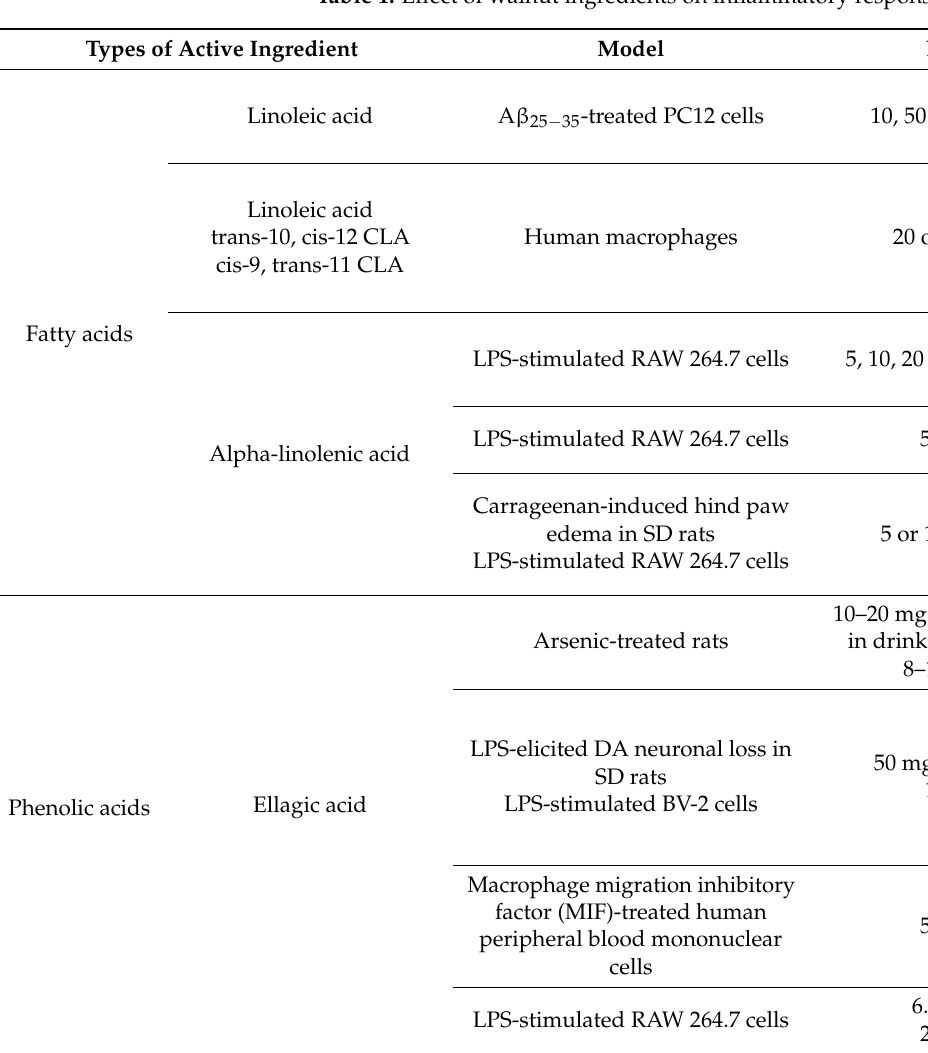
Table 1. Effect of walnut ingredients on inflammatory responses of neuronal and peripheral immune